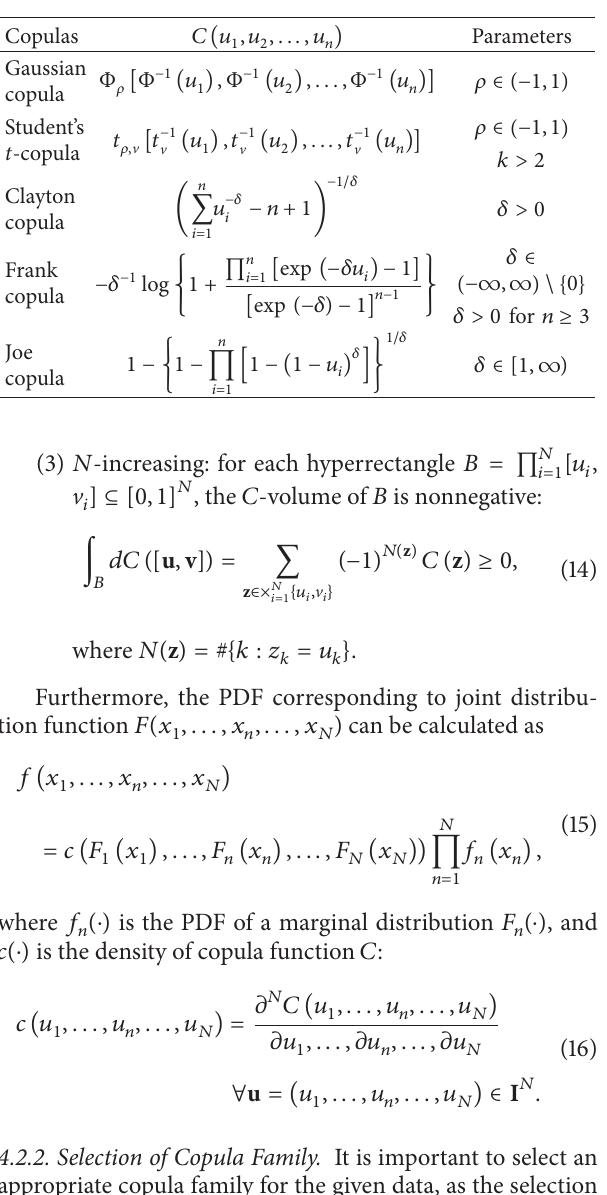
Table 2: Typical multivariate